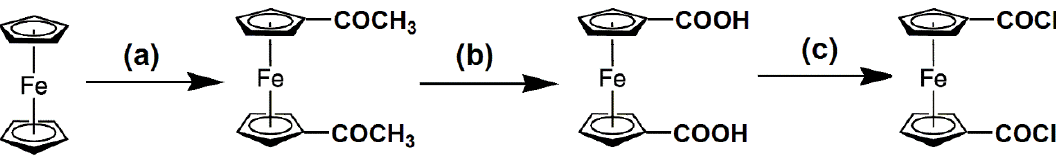
Figure 1. Synthesis of 1,1′ -ferrocenedicarbonyl chloride.